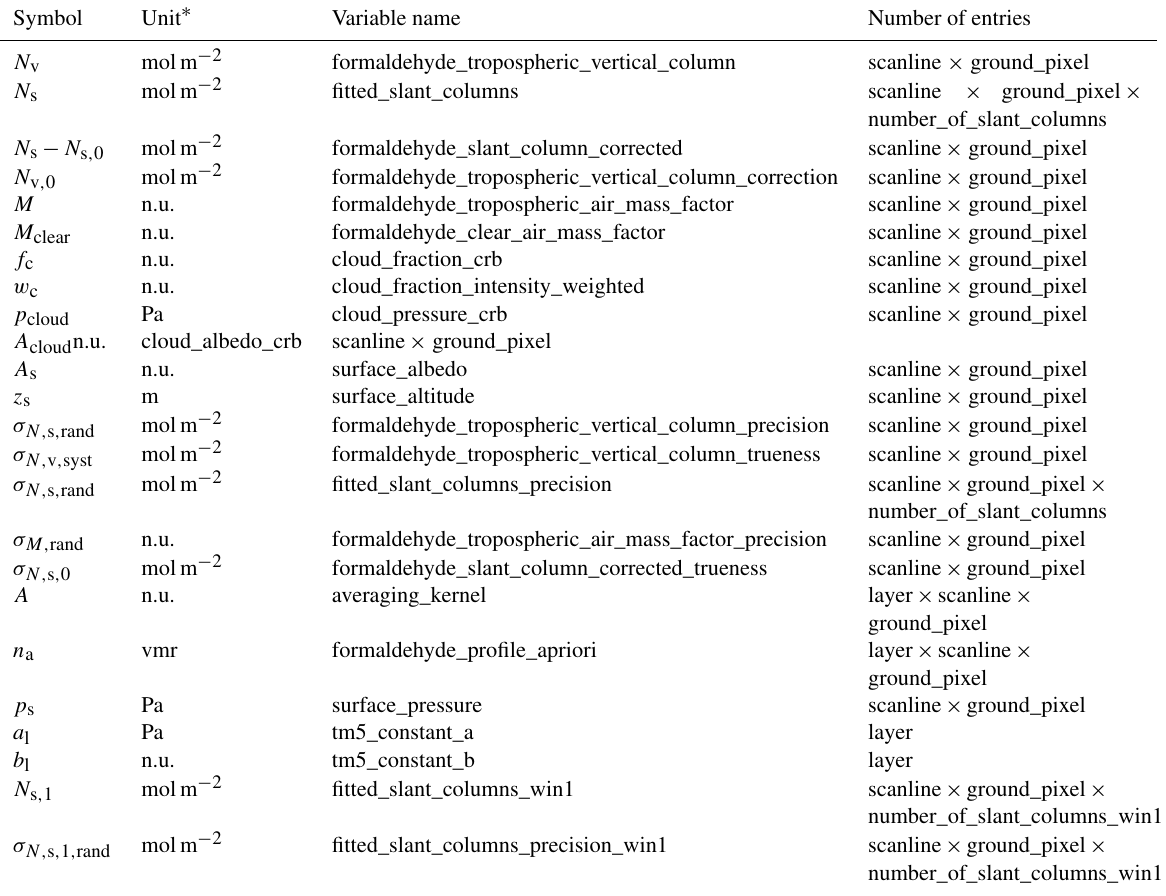
Table B1. Selective list of output fields in the TROPOMI HCHO product. Scanline and ground_pixel are, respectively, the number of pixels in an orbit along track and across track. Layer is the number of vertical levels in the averaging kernels and the a priori